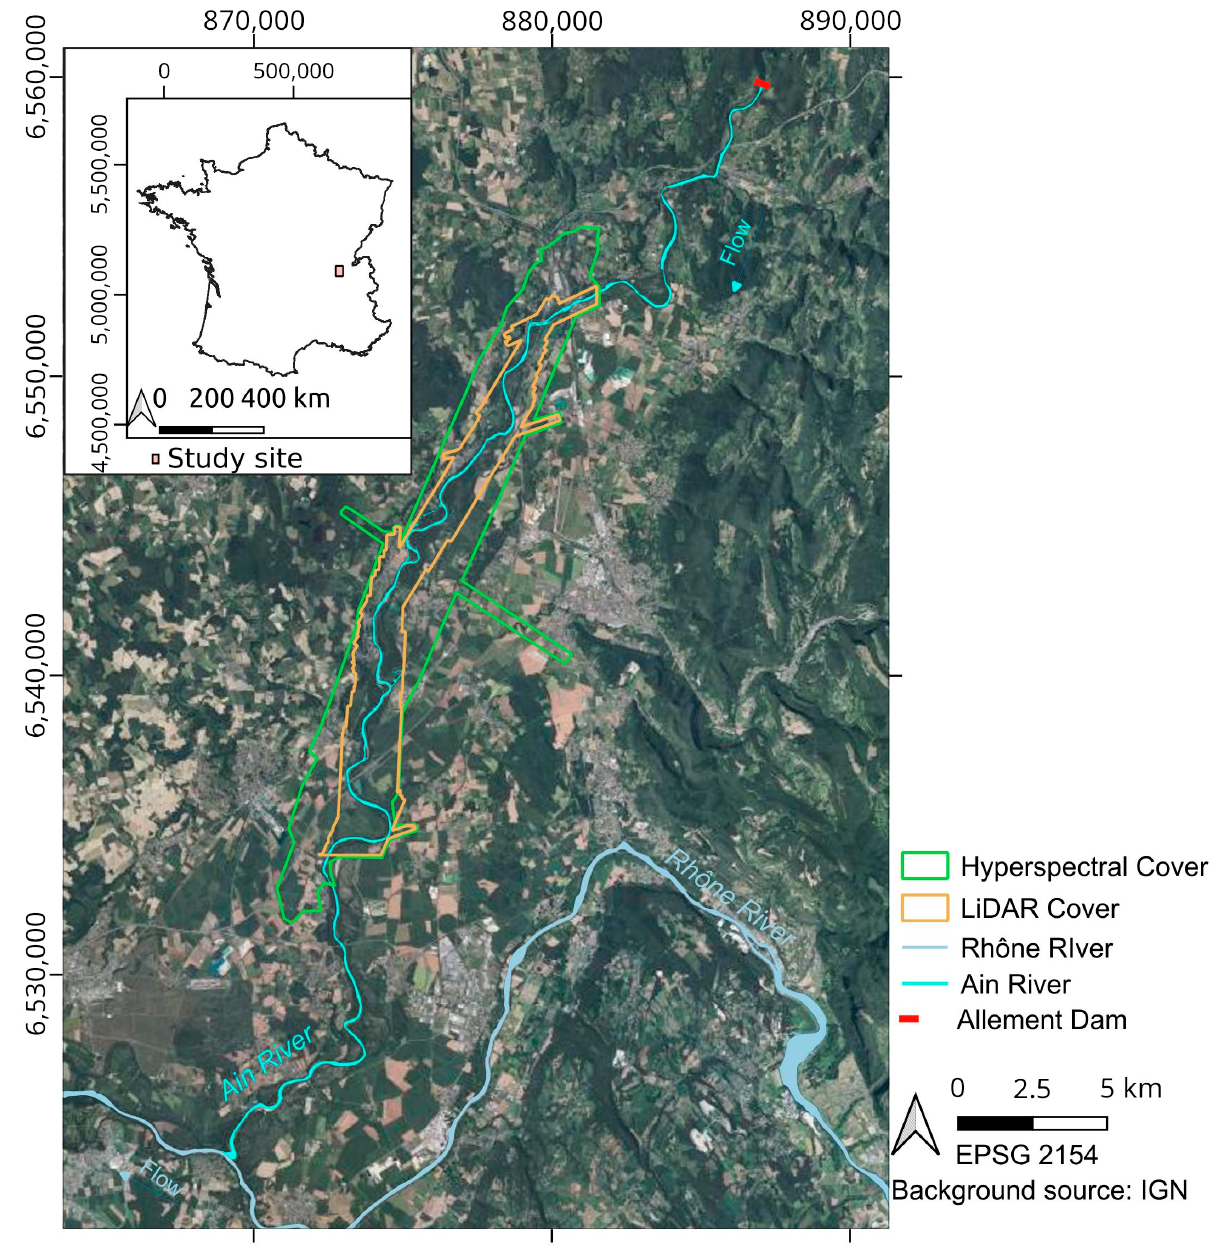
Figure 1. Map of the study site: the lower Ain River, France.